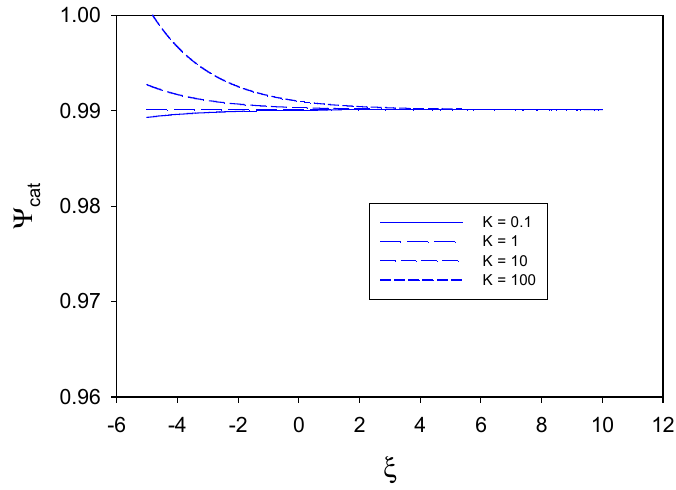
Figure 4. Variation of catalytic efficiency with normalized potential for heterogeneous redox catalysis via the bimolecular mechanism for the case of slow substrate diffusion to the redox active